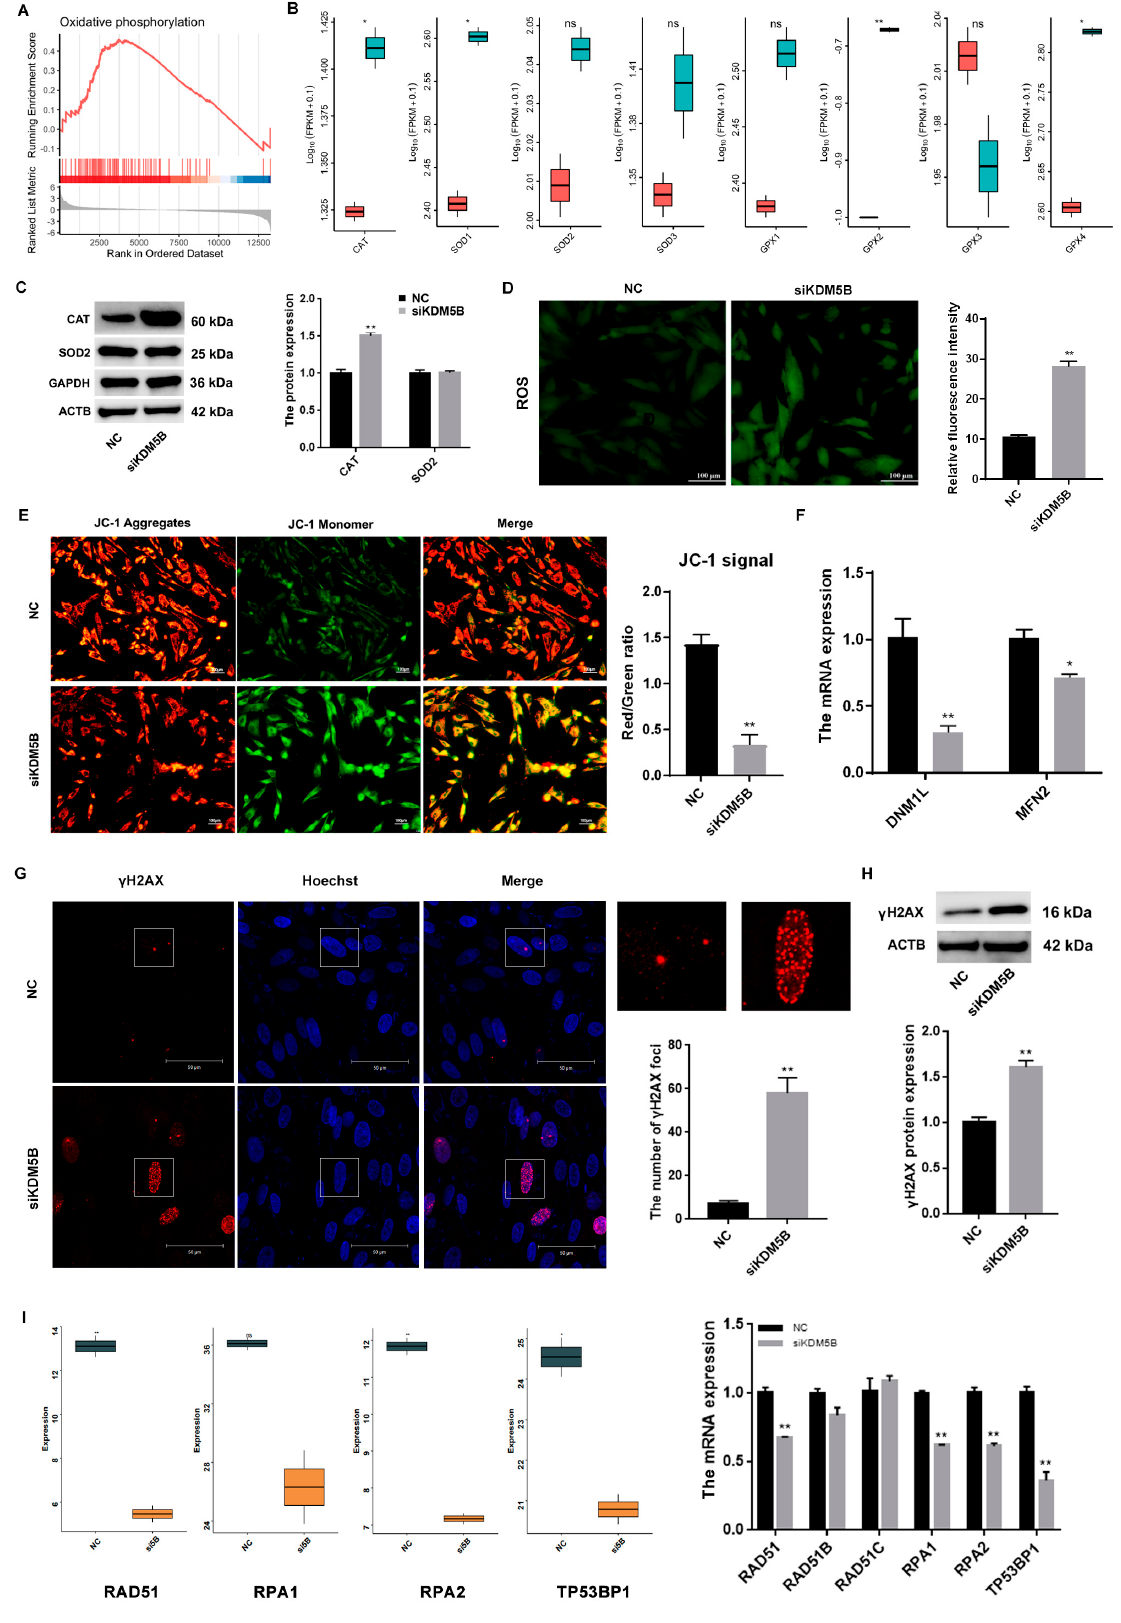
Figure 4. Increased oxidative stress level and DNA damage in KDM5B knockdown GCs. ( A ) Enriched KEGG items revealed by GSEA. DEGs indicate differentially expressed genes. ( B ) mRNA